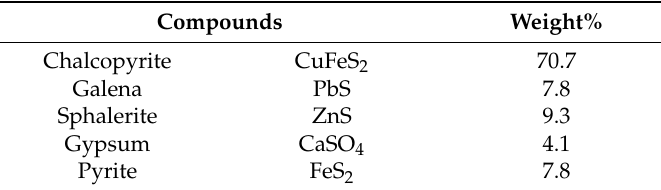
Table 3. Mineralogical reconstruction of the chalcopyrite concentrate.